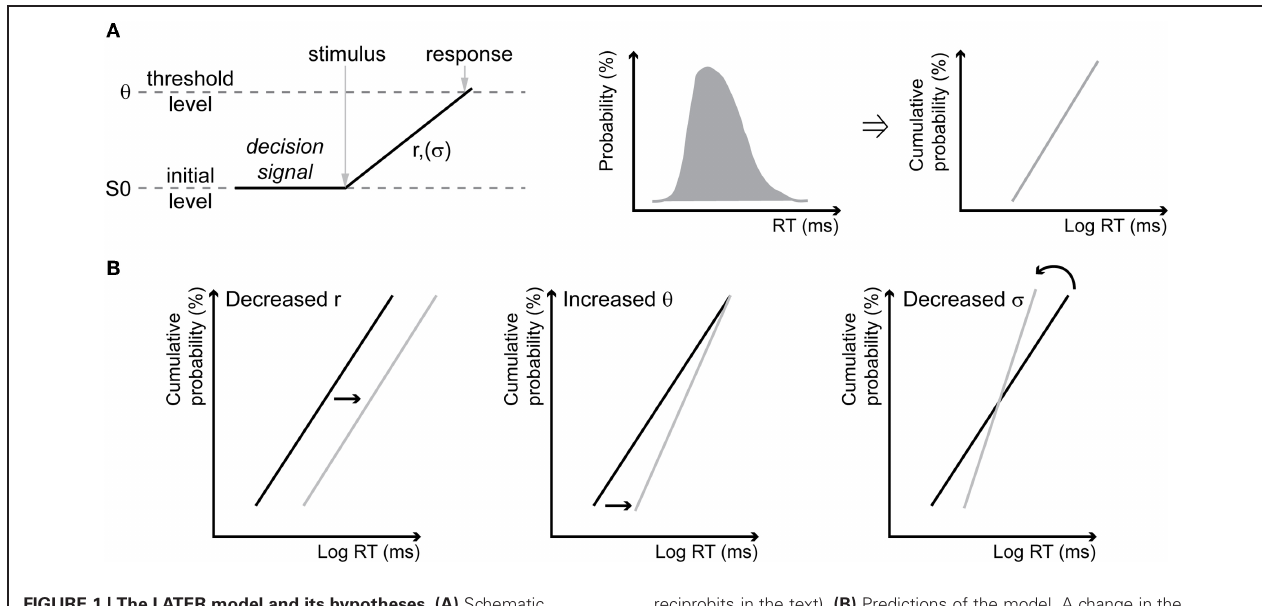
FIGURE 1 | The LATER model and its hypotheses. (A) Schematic illustrations of the LATER model. Following the presentation of a stimulus, a decision signal rises linearly, with an accumulation rate r that has a variance σ , from a baseline value S0 to a decision threshold θ , at which point the response is produced (left). The cumulative reaction times distribution (middle) is plotted on a probit scale with a reciprocal time axis (right) resulting in a line according to the model (called